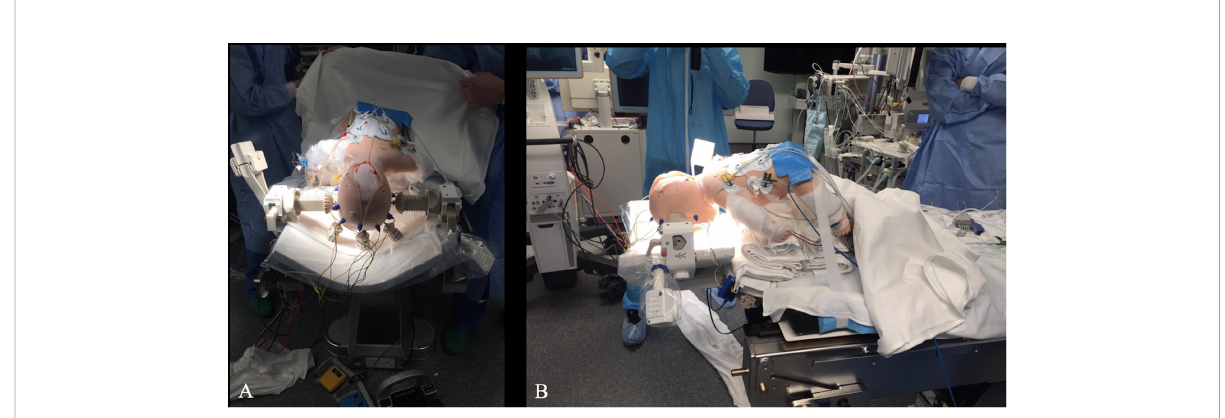
FIGURE 1 (A, B) Images of one of the pediatric models used in the simulation session for the validation of the ioMRI checklist carried out by the different teams involved in this work fl